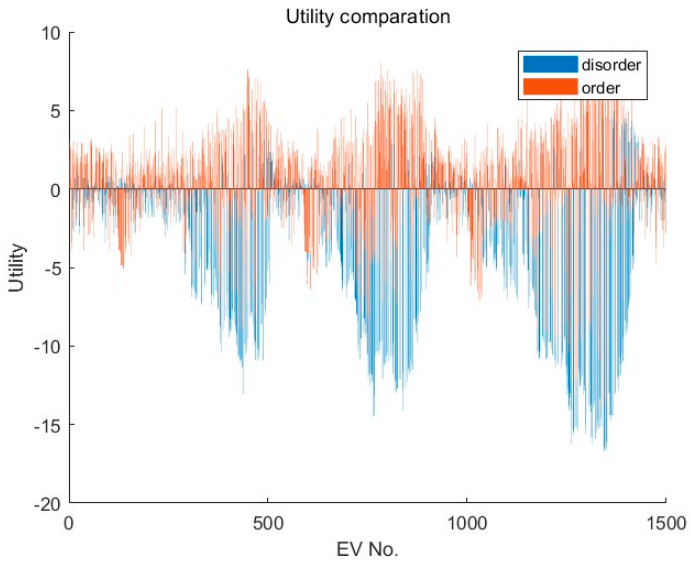
Figure 11. Utility value comparison under orderly and disorderly charging.